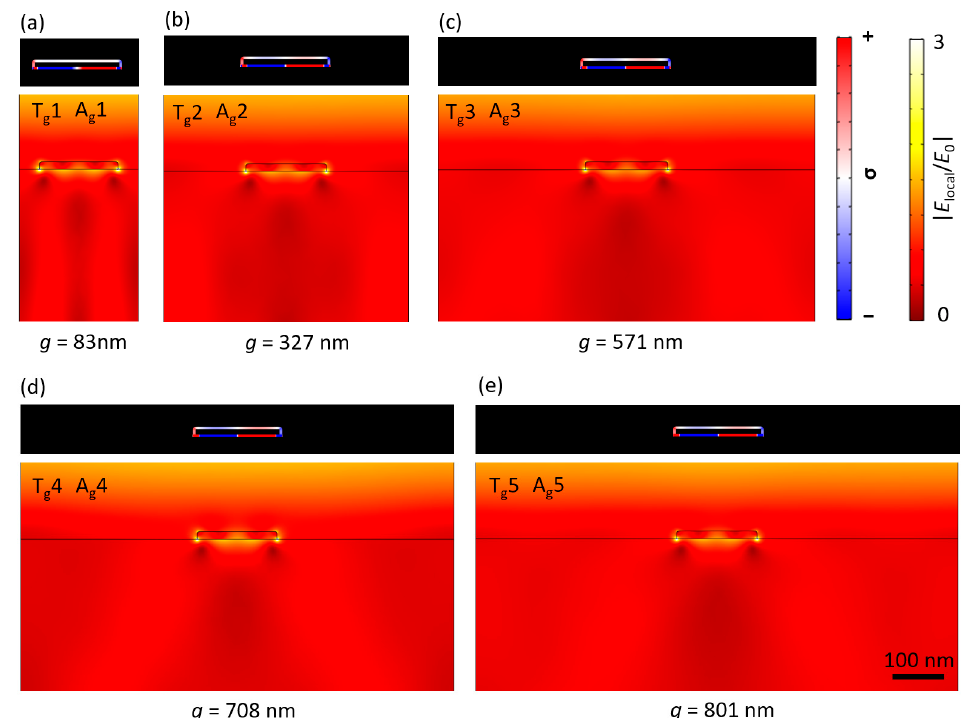
Figure 4. The electric field and charge distributions at Rayleigh’s anomaly as shown in Figure 3 for sweeping ( g ). ( a ) T g 1 or A g 1 at P = 243 nm, ( w = 160 nm and g = 83 nm); ( b ) T g 2 or A g 2 at P = 487 nm, ( w = 160 nm and g = 327 nm); ( c ) T g 3 or A g 3 at P = 731 nm ( w = 160 nm and g = 571 nm); ( d ) T g 4 or A g 4 at P = 868 nm, ( w = 160 nm and g = 708 nm); and ( e ) T g 5 or A g 5 at P = 961 nm ( w = 160 nm and g = 801 nm).